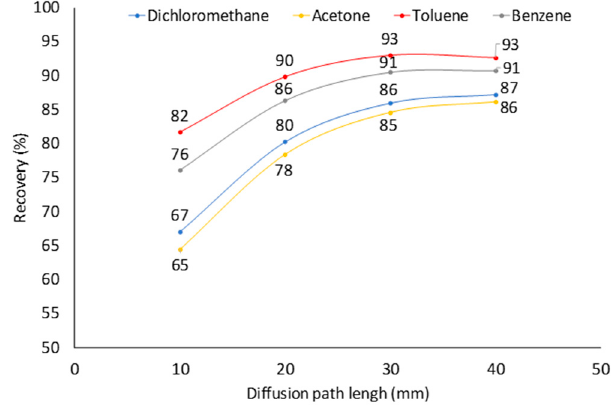
Figure 6. Effect of diffusion path length on recoveries of four analytes ( C = 0.641 μ mol · m − 3 ) after sampling for 100,000 s using 23 ga Car/PDMS fiber assembly.